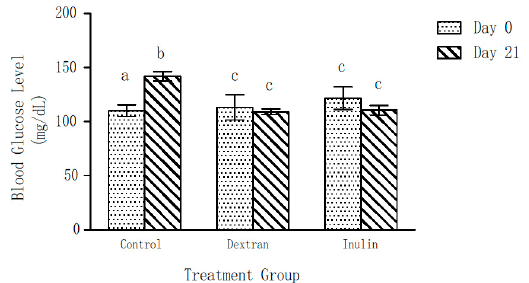
Figure 3. Effect of inulin and dextran type polysaccharides on blood glucose level of mice. The error bars represent standard error of the mean (SEM). a p < 0.05, compared with the blood glucose level at Day 21 within the control group b p < 0.05, compared with the blood glucose level at Day 0 within the control group. c p < 0.05, blood glucose levels of the dextran- and inulin-fed groups compared with the control group at Day 21.